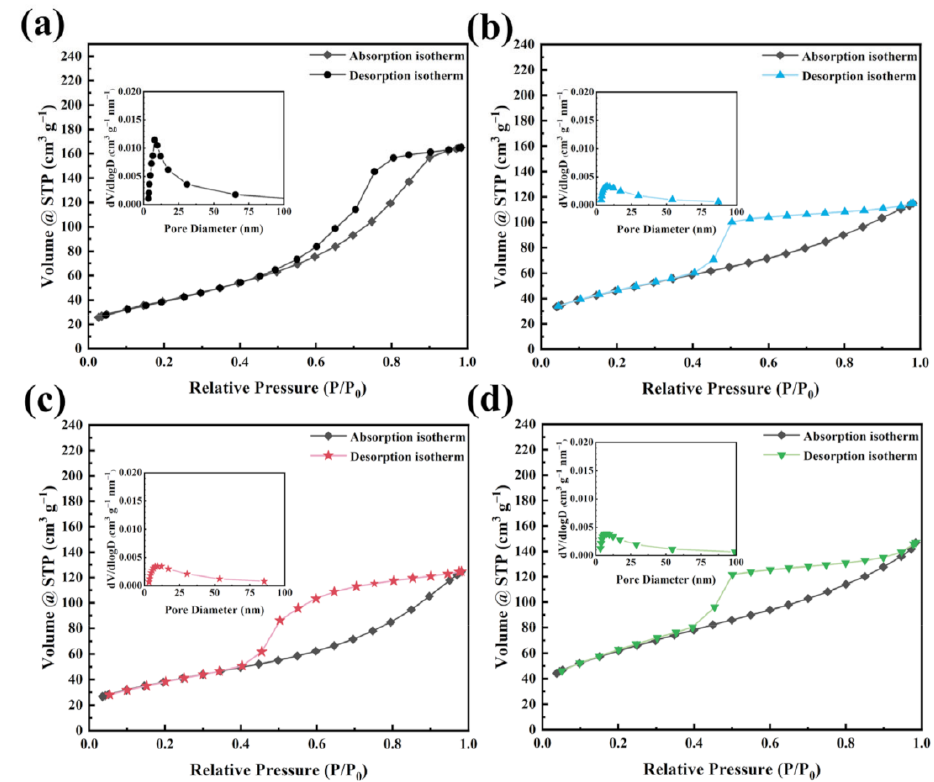
Figure 3. N 2 adsorption-desorption isotherms and pore size distribution of ( a ) ZnFe 2 O 4 , ( b ) ZnFe 2 O 4 /rGO − 1, ( c ) ZnFe 2 O 4 /rGO − 2, and ( d ) ZnFe 2 O 4 /rGO −